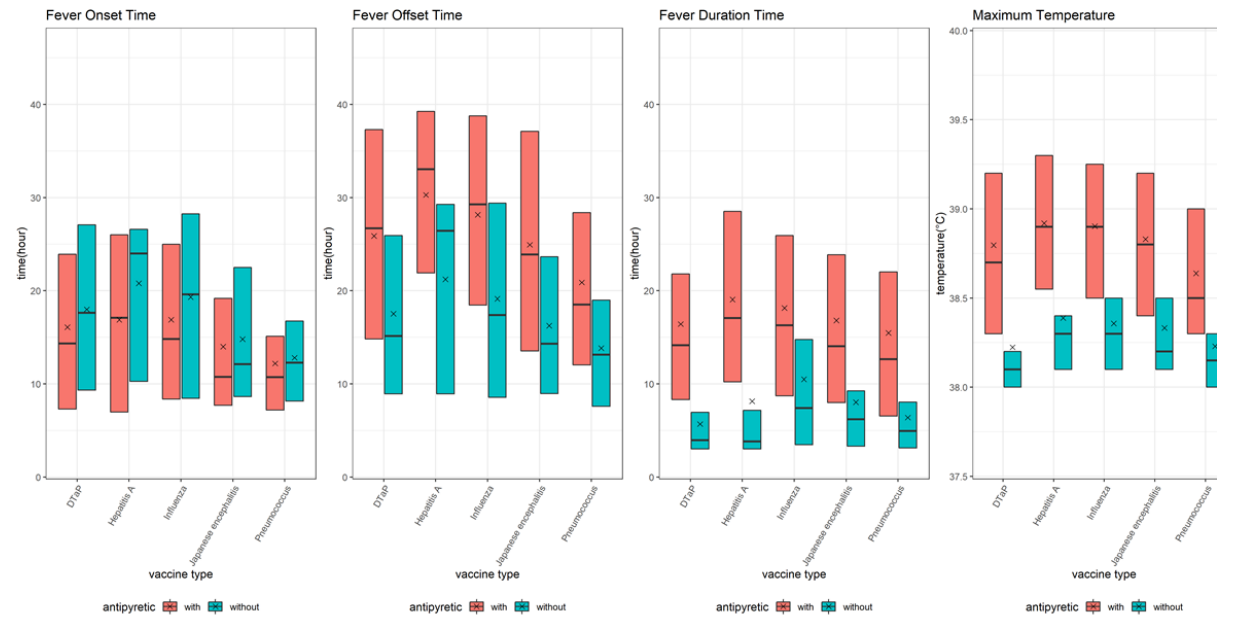
Figure 5. Comparison of onset, offset, duration times, and maximum temperatures among vaccine types, and the effects of antipyretics on postvaccination fever response. From left to right: box plots of onset, offset, duration times, and maximum body temperature are depicted. The bar indicates the median; x indicates the